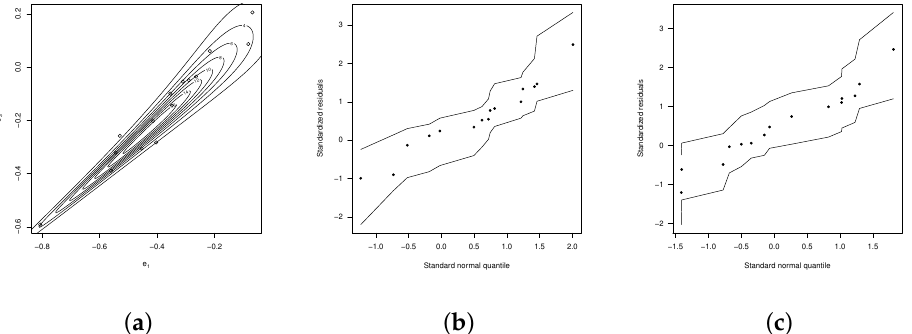
Figure 5. ( a ) Contour plot RBSHPN model. ( b ) Marginal envelope e 1 SHN model. ( c ) Marginal envelope e 2 SHN